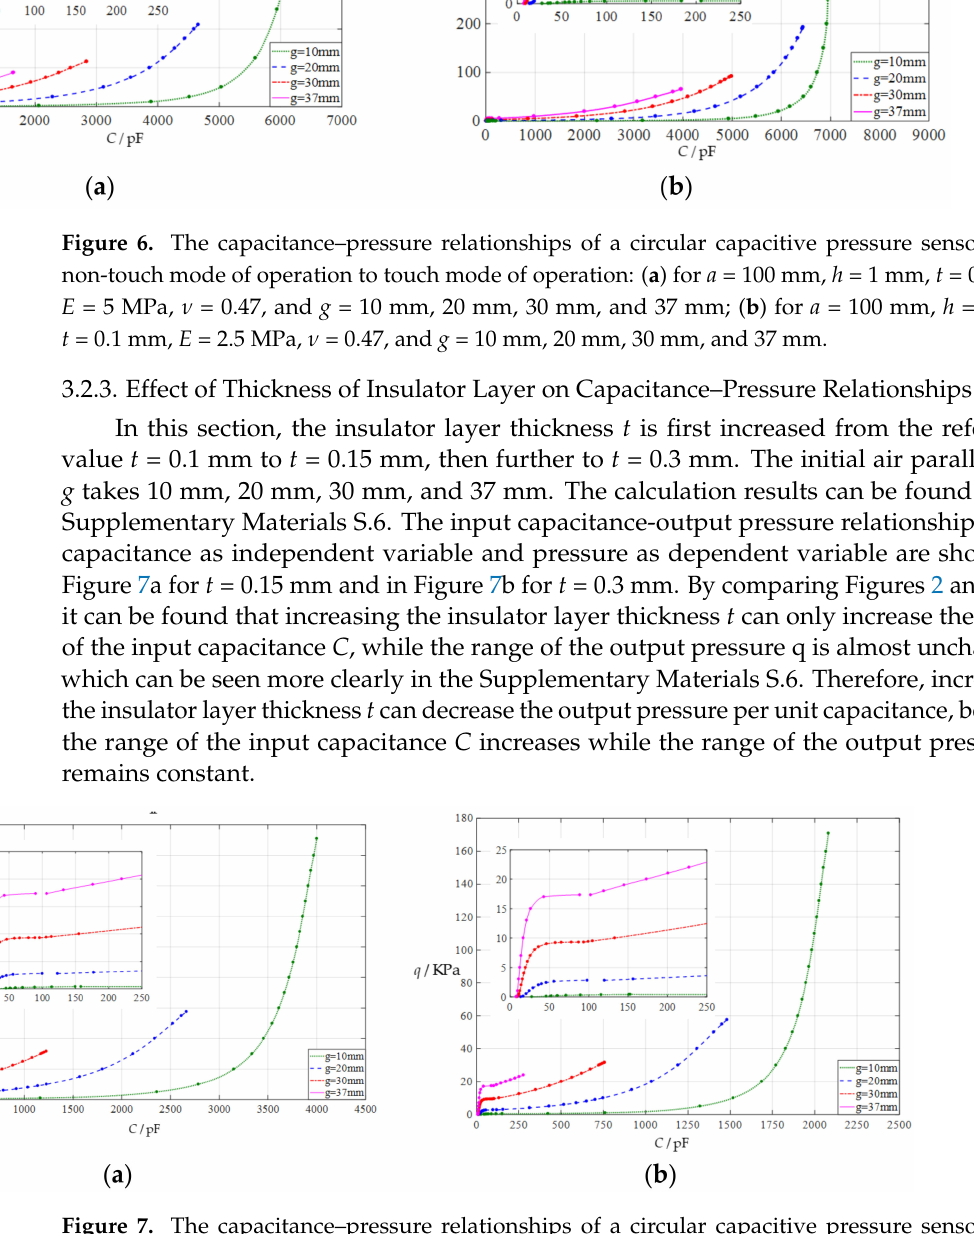
Figure 7. The capacitance–pressure relationships of a circular capacitive pressure sensor from non-touch mode of operation to touch mode of operation: ( a ) for a = 100 mm, h = 1 mm, t = 0.15 mm, E = 7.84 MPa, ν = 0.47, and g = 10 mm, 20 mm, 30 mm, and 37 mm; ( b ) for a = 100 mm, h = 1 mm, t = 0.3 mm, E = 7.84 MPa, ν = 0.47, and g = 10 mm, 20 mm, 30 mm, and 37